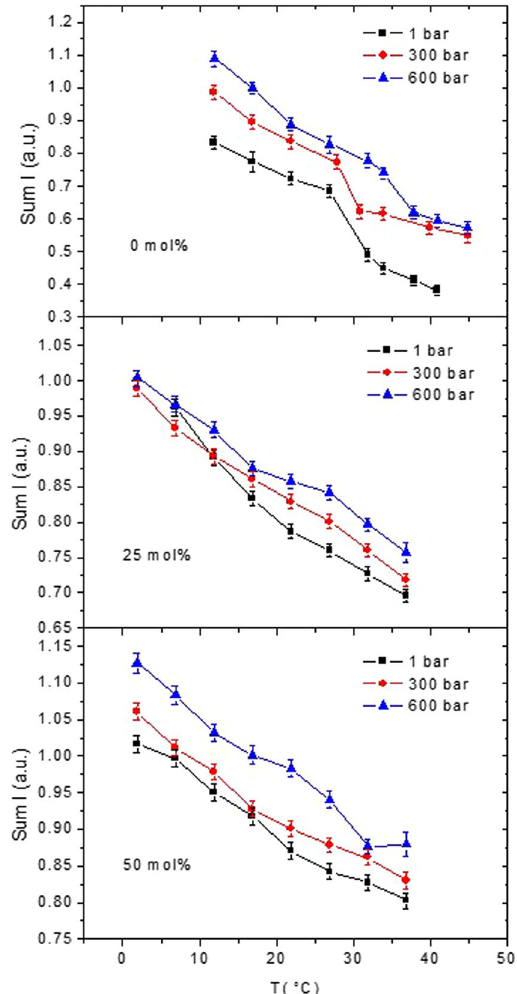
Figure 2. Summed elastic intensities of pure DMPC (reproduced from ref. 31 ) and DMPC/cholesterol mixtures, rescaled for the total amount of lipids, measured on IN13. Data at atmospheric pressure are shown as black squares, data taken at 300 bar as red circles and data recorded at 600 bar as blue triangles. Data are summed over the complete Q-range available on IN13 (0.29 Å − 1 < Q < 4.98 Å − 1 ). Lines connecting the data points are guide to the eyes